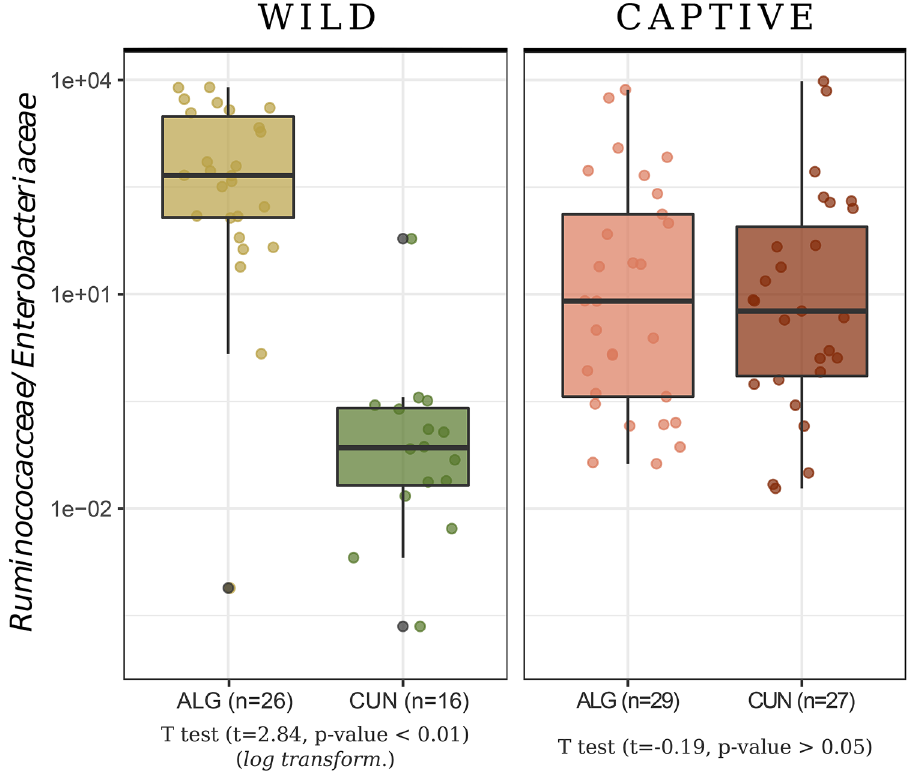
Figure 7. Comparison of the gut functional enrichment index (ratio between relative abundance of Ruminococcaceae and Enterobacteriaceae ) between subspecies for captive and wild groups. ALG: O. c. algirus. CUN: O. c. cuniculus